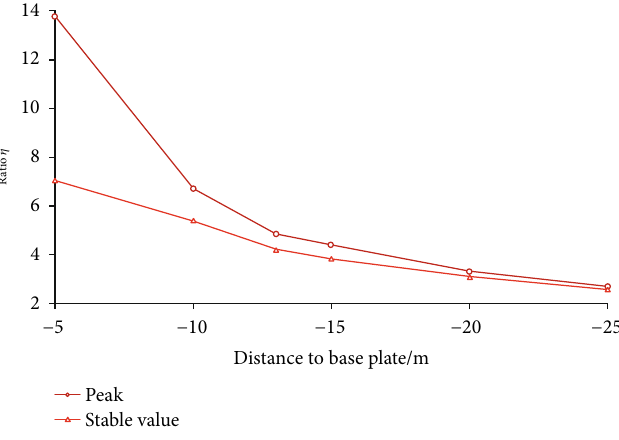
Figure 13: Peak and stable value of the ratio of two-way stress at di ff erent